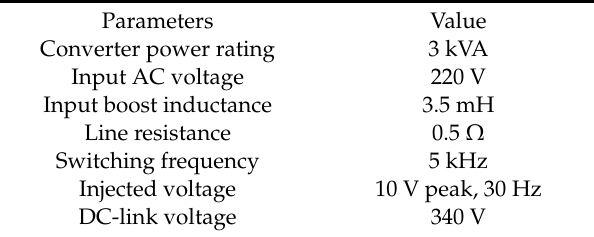
Figure 6. System hardware configuration. Table 3. System parameters.